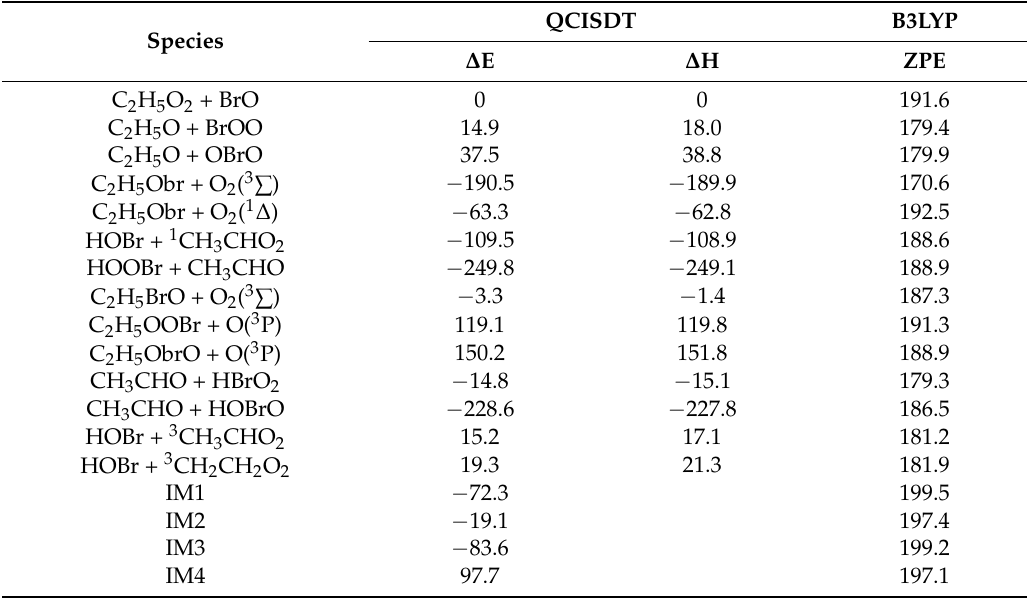
Table 2. The Zero-point energy correction (ZPE), relative energies with ZPE including ( ∆ E) and reaction enthalpy ( ∆ H) (in kJ/mol) in the C 2 H 5 O 2 + BrO reaction. QCISDT B3LYP Species